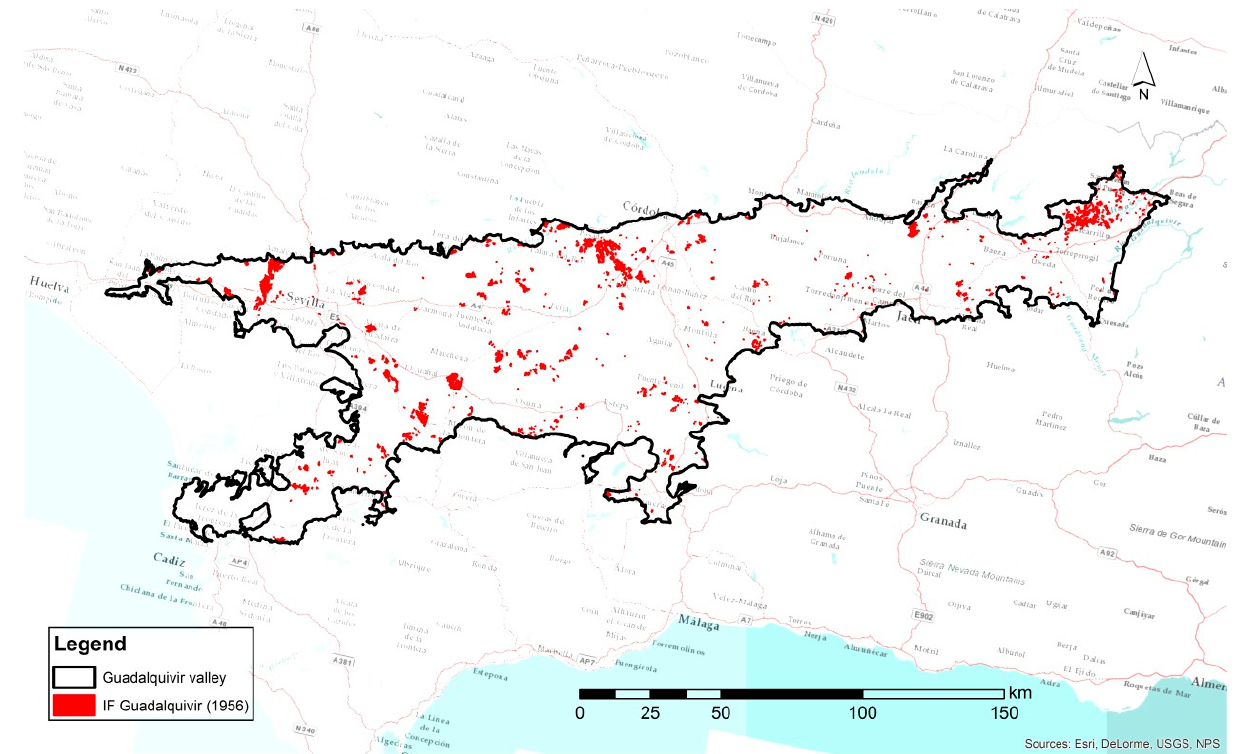
Figure 4. Distribution of IF in the Guadalquivir valley in 1956.